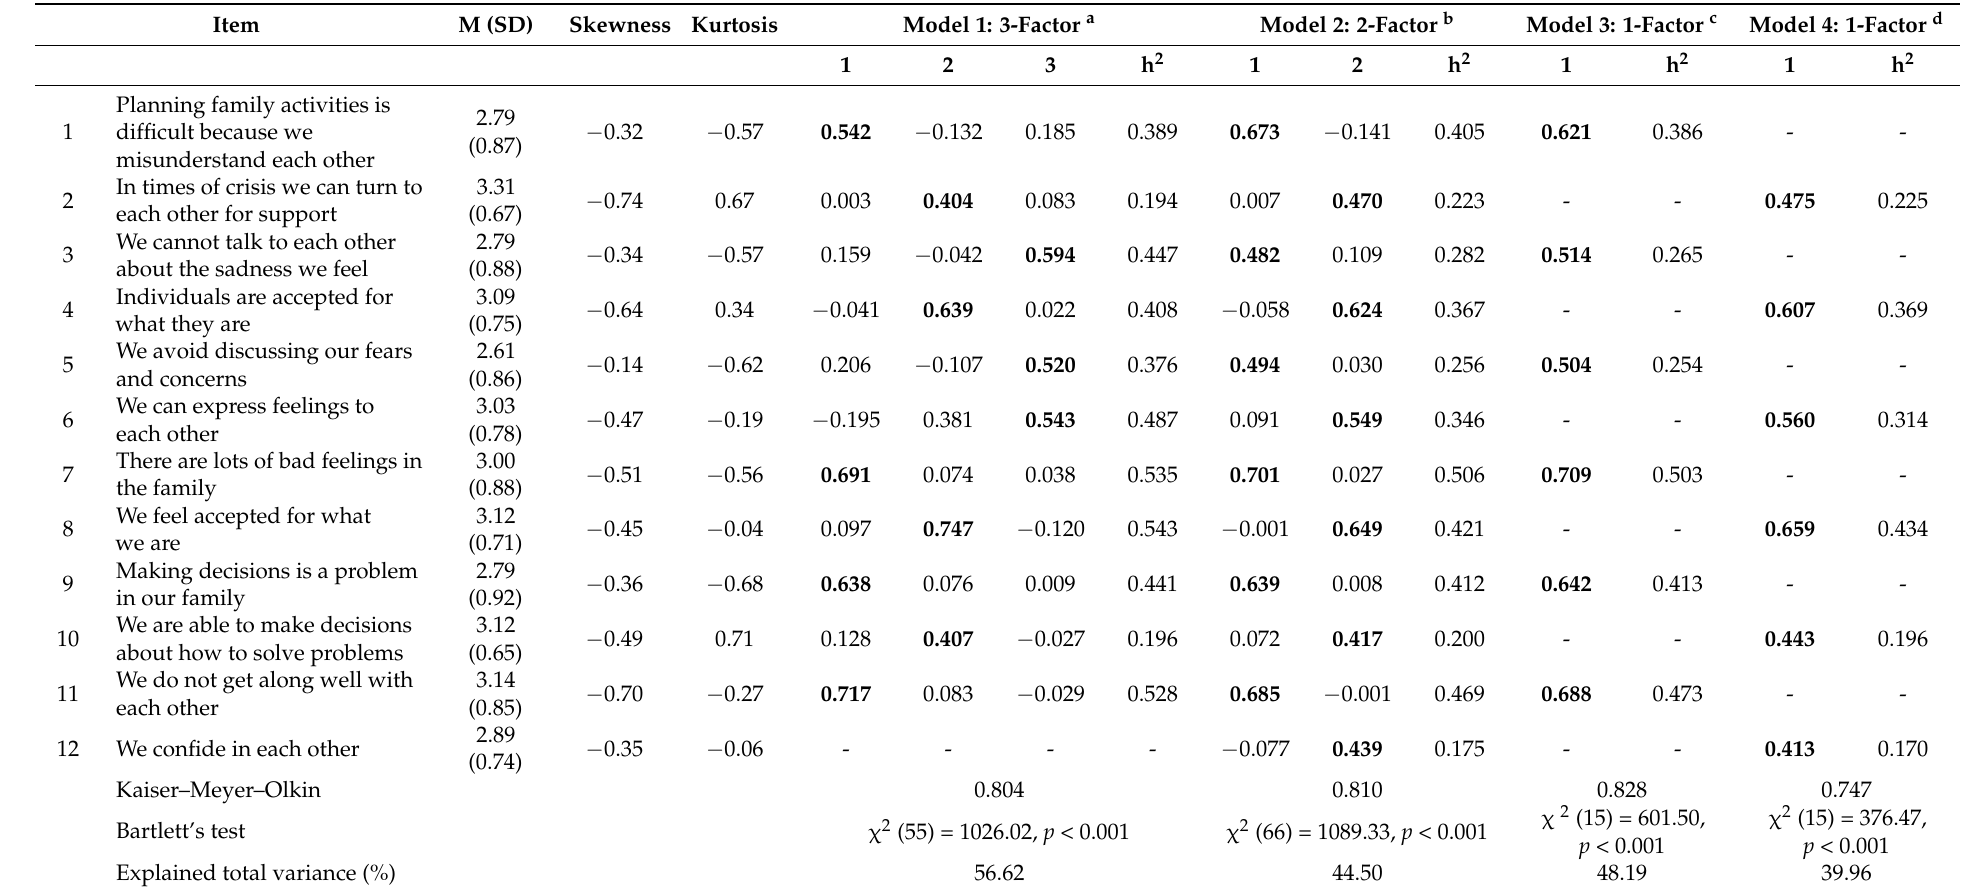
Table 1. Summary of exploratory factor analysis results in Study